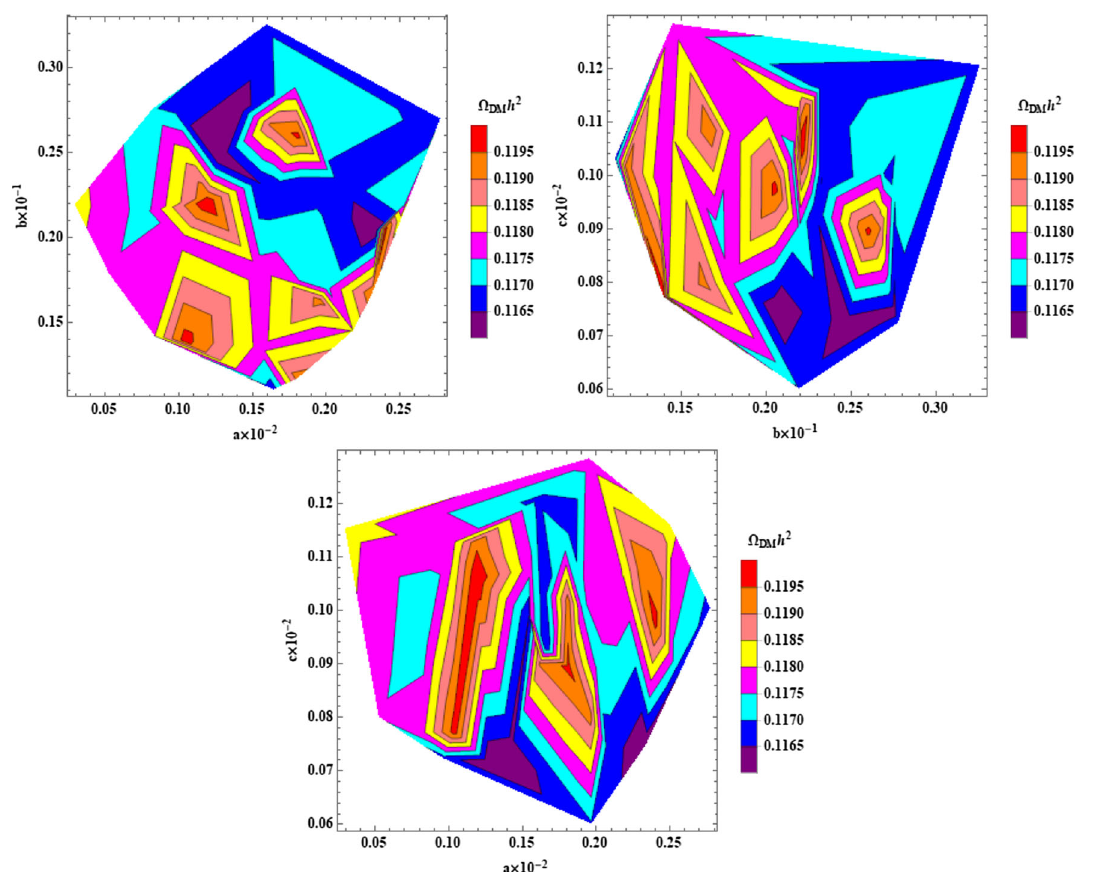
Fig. 12 Contour plot relating the model parameters a and b w.r.t the relic abundance ( (cid:20) DM h 2 ) of the DM candidate ( ξ ) (left panel), right panelshowsvariationofbandcwith (cid:20) DM h 2 andinthemiddleweshow